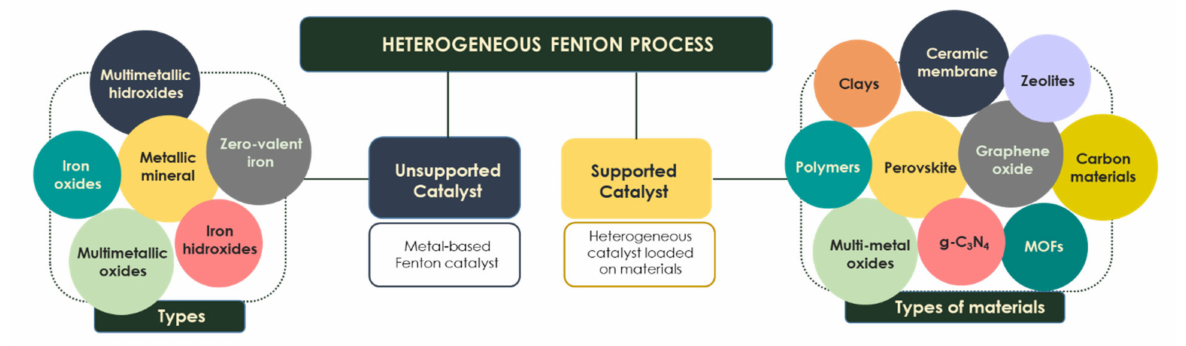
Figure 2. Types of catalysts in the Fenton